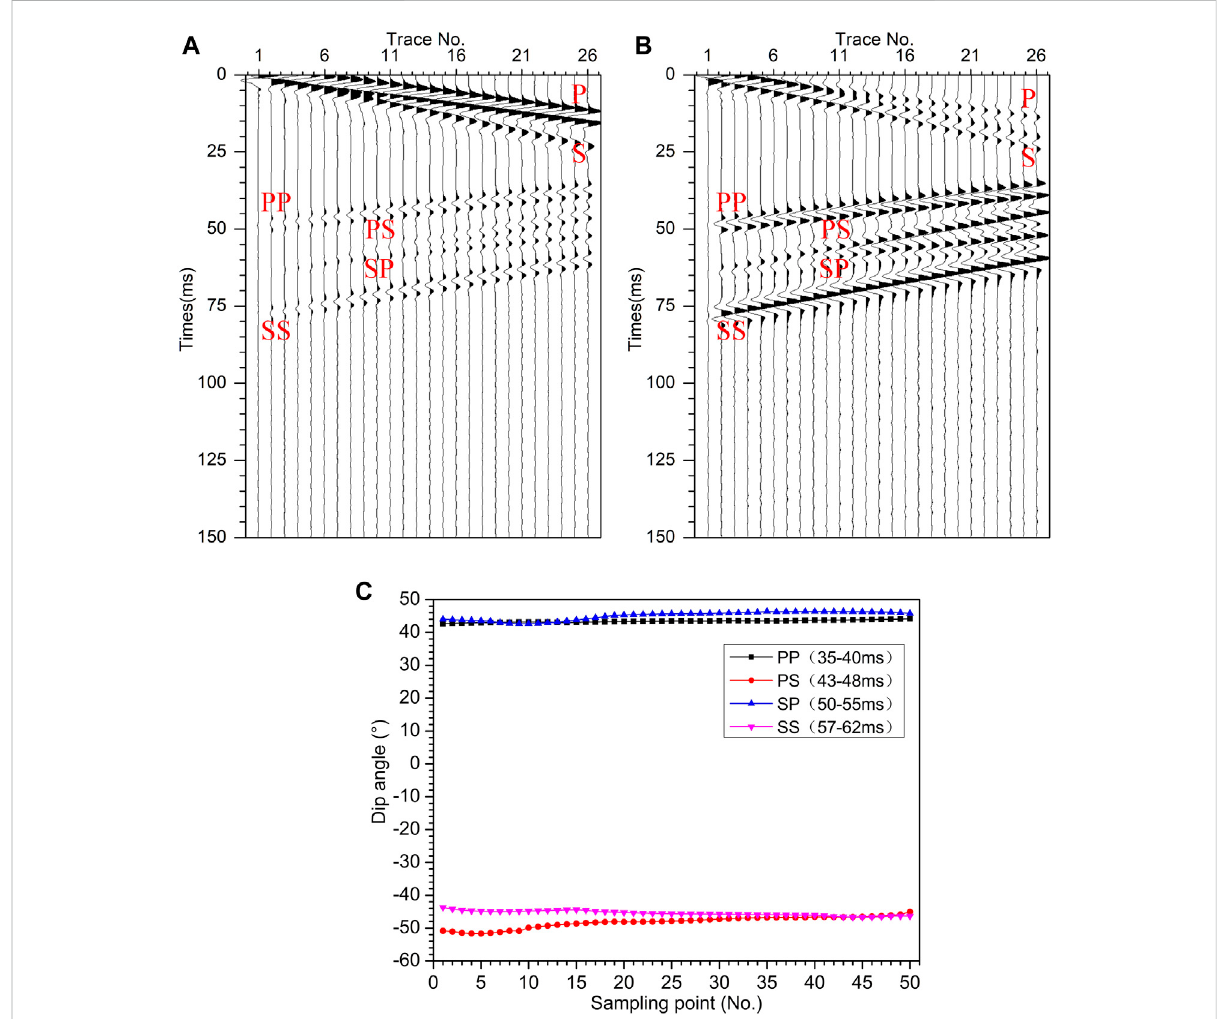
T e . Figure 7 are the P-wave and S-wave CSP (PCSP and SCSP) gathers of the model respectively. As shown in the fi gure, affected by polarization fi ltering, only the PP scattered waves in the PSCP 41 gather that are located at the true re fl ection position of the fault are obvious, while the interference signals in the other gathers (PCSP 11 and PCSP 26) located at false re fl ection position of the fault are obviously suppressed. The